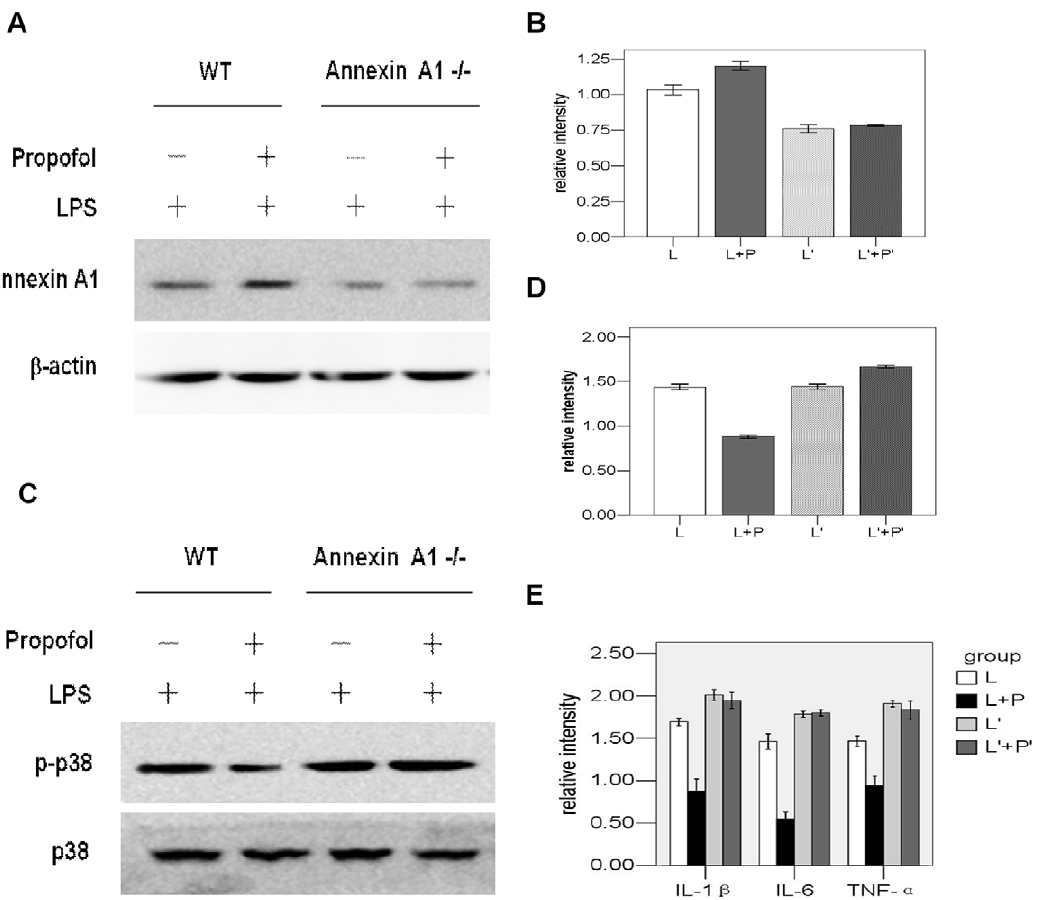
Figure 7. The impact of propofol on phosphorylation of p38 and the release of IL-1 b , IL-6 and TNF- a under LPS stimulation after inhibition of Annexin A1 in THP-1. A. Lysis samples of THP-1 cells were separated on 12% SDS-PAGE gels and transferred to PVDF membranes for Western blotting analysis of Annexin A1. B. Gray intensity analysis of the western blot results of six groups. Each bar represents the mean 6 S.D. No significant differences were found between L’ group and L’ + P’ Group (p . 0.05). L group: LPS group with wide-type Annexin A1; L + P group: LPS + propofol group with wide-type Annexin A1 ; L’ group: LPS group with transfected shRNA of Annexin A1; L’ + P’ group: LPS + propofol group with transfected shRNA of Annexin A1. C. Lysis samples of THP-1 cells were separated on 12% SDS-PAGE gels and transferred to PVDF membranes for Western blotting analysis of phosphorylation of p38. D. Gray intensity analysis of the western blot results of four groups. Each bar represents the mean 6 S.D. No significant differences were found between L’ group and L’ + P’ Group (p . 0.05). L group: LPS group with wide-type Annexin A1; L + P group: LPS + propofol group with wide-type Annexin A1 ; L’ group: LPS group with transfected shRNA of Annexin A1; L’ + P’ group: LPS + propofol group with transfected shRNA of Annexin A1. E. the experession of mRNA of TNF- a IL-1 b , IL-6 in THP-1 cells. Each bar represents the mean 6 S.D, no significant differences were found L’ + P’ group compared with L’ group.